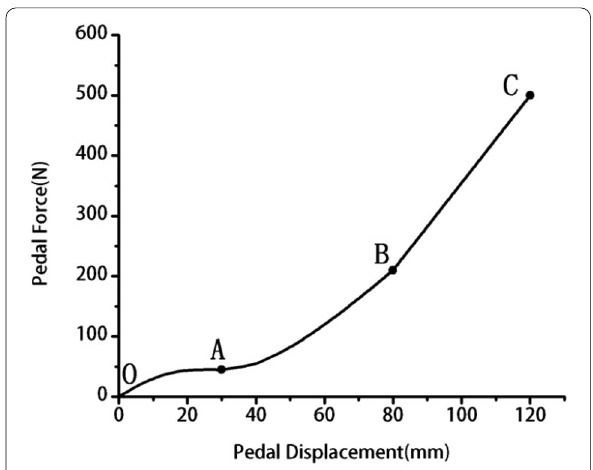
Figure 6 Relationship between the pedal force and pedal displacement for a CHB